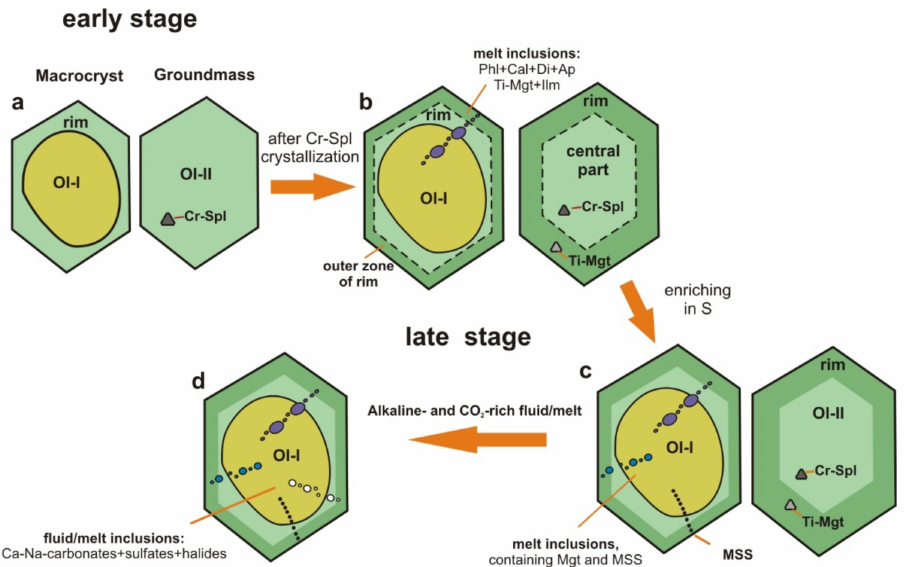
Figure 13. The scheme of olivine crystallization and trapping inclusions (mineral and melt/fluid) at different stages of aillikite melt evolution (not to scale). ( a ) Liquidus olivine crystallization: central part of groundmass olivines (Ol-II) and rim of the olivine macrocrysts (Ol-I), together with Cr-spinels (Cr-Spl) at the early stage of aillikite formation. ( b ) Crystallization of olivine groundmass rims and capture of Ti-rich magnetite grains (Ti-Mgt); penetration of aillikite melt through fissures in the olivine macrocrysts with the subsequent formation of the secondary melt inclusions of phlogopite (Phl), calcite (Cal), diopside (Di), apatite (Ap), Ti-rich magnetite and ilmenite (Ilm). ( c ) Capture of S-enriched melt by macrocrysts at the late stage of aillikite evolution, and the formation of melt and mineral inclusions containing monosulfide solution (MSS) (pyrrhotite and pentlandite). ( d ) Trapping of inclusions, which mainly consists of alkaline carbonates and sulfates at the last stage of the aillikites